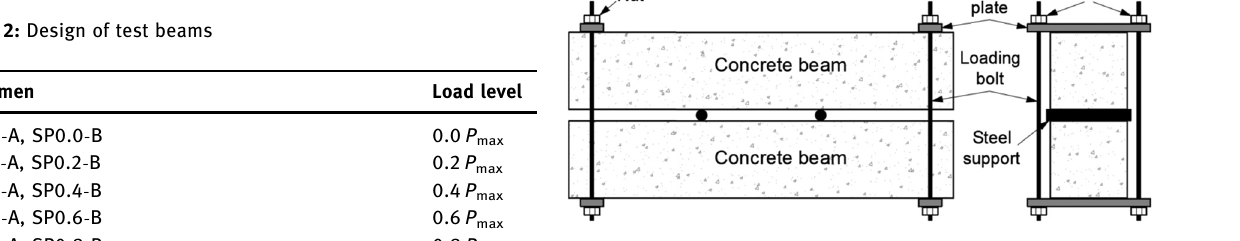
Figure 5: Diagram of the loading